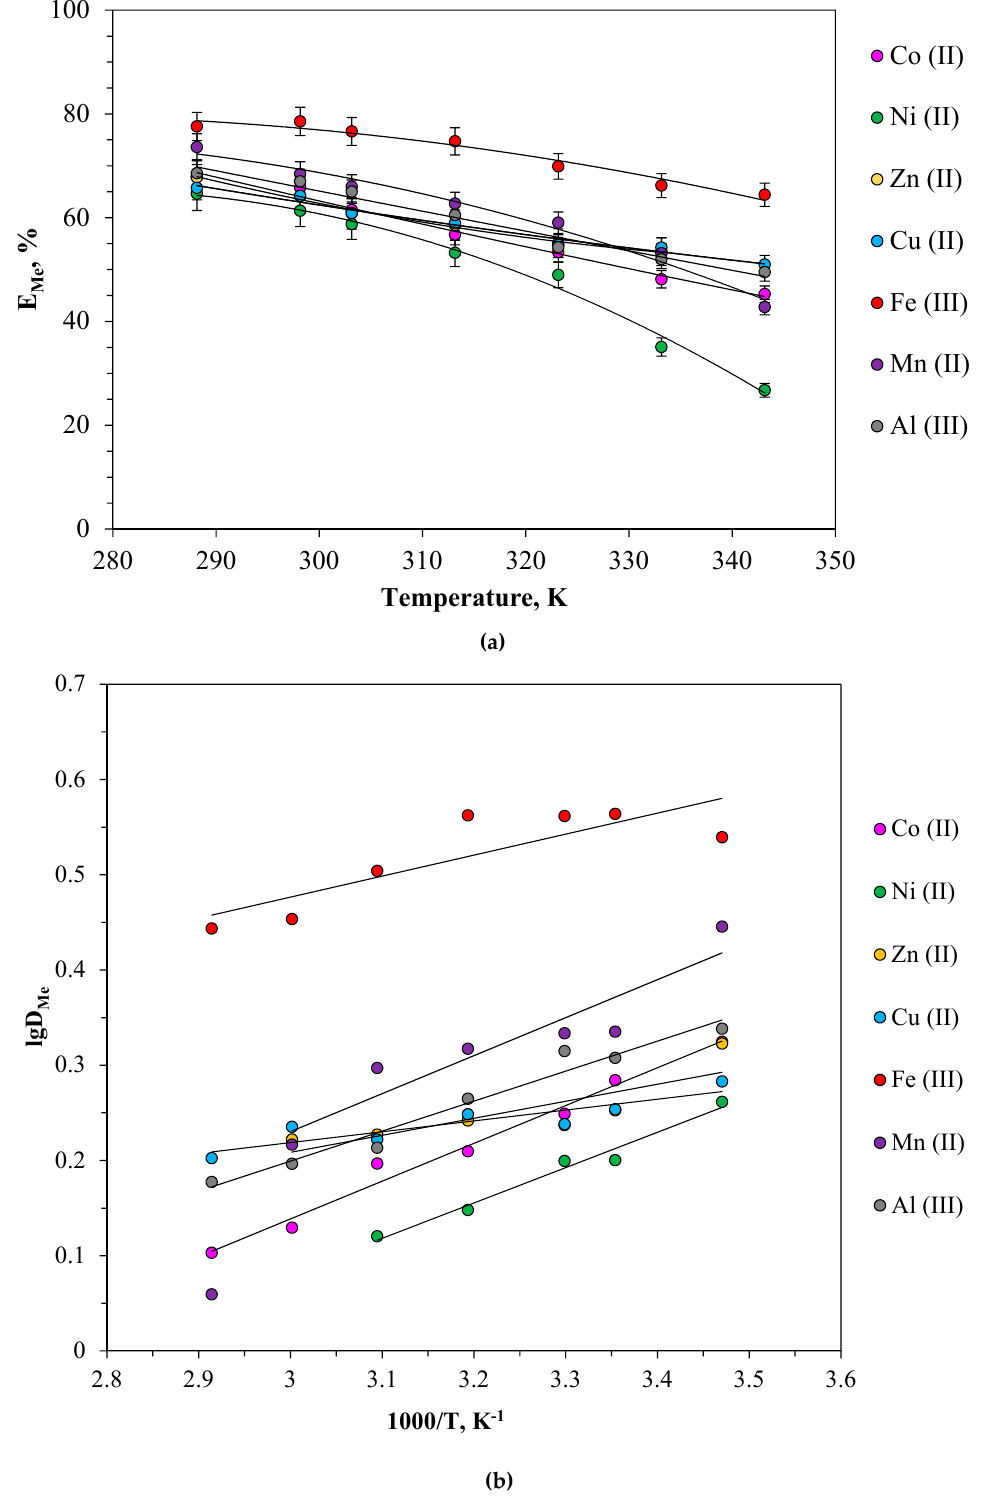
Figure 5. ( a ) Effect of temperature on the metal extraction; ( b ) plot of lgD Me vs. 1000/T. Conditions: Figure 5. ( a ) E ff ect of temperature on the metal extraction; ( b ) plot of lgD Me vs. 1000 / T. Conditions: PEO 1500 (16.3 wt%)-NaNO 3 (36.0 wt%)-H 2 O system, [Me] in = 0.01 mol·L − 1 . PEO 1500 (16.3 wt%)-NaNO 3 (36.0 wt%)-H 2 O system, [Me] in = 0.01 mol · L − 1